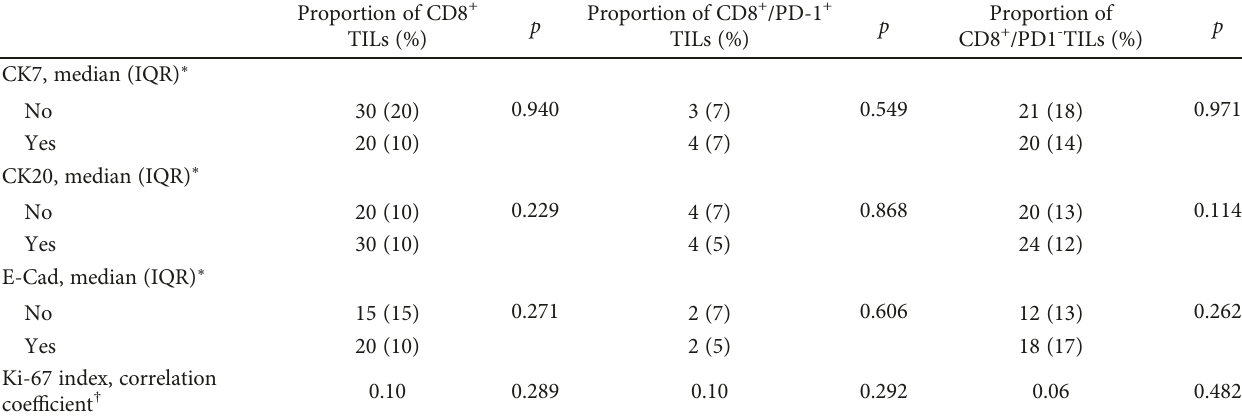
Table 4: Correlation between proportion of CD8/PD-1 TILs and other molecules in breast cancer.